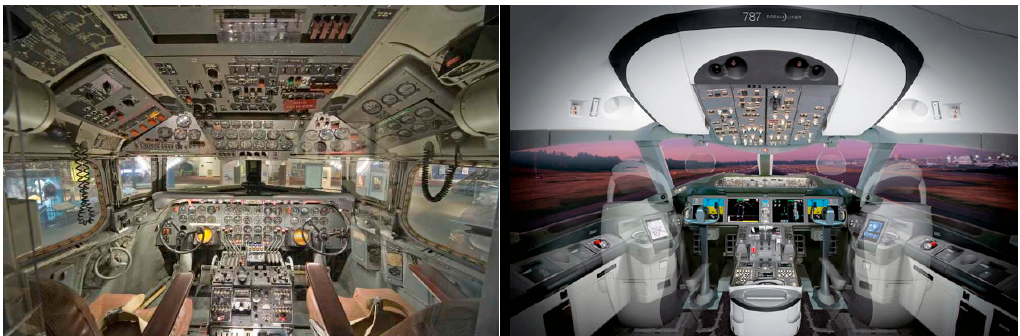
Figure 2. Flight deck of a Douglas DC-7 (left) [21] and Boeing 787-9 (right) [22].